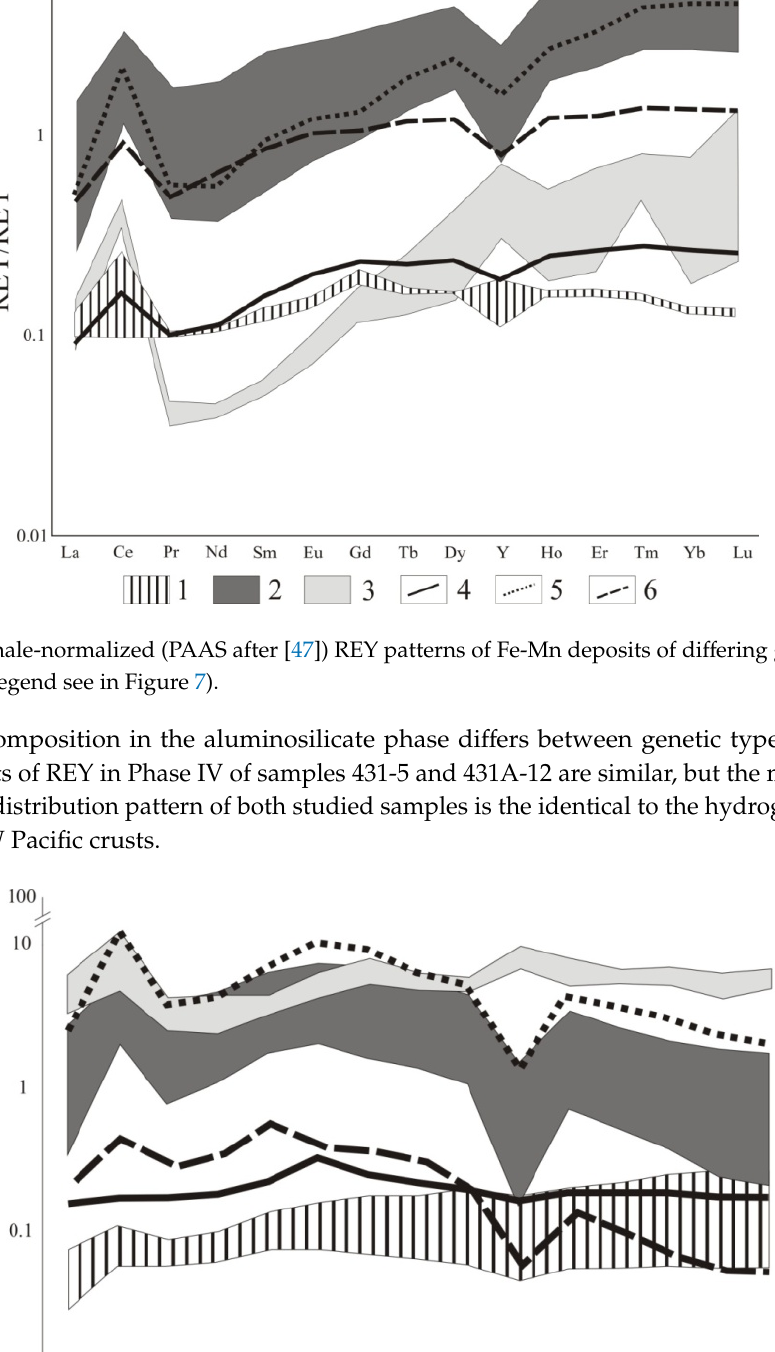
Figure 11. Shale-normalized (PAAS after [47]) REY patterns of Fe-Mn deposits of differing genesis in fraction IV (legend see in Figure 7).